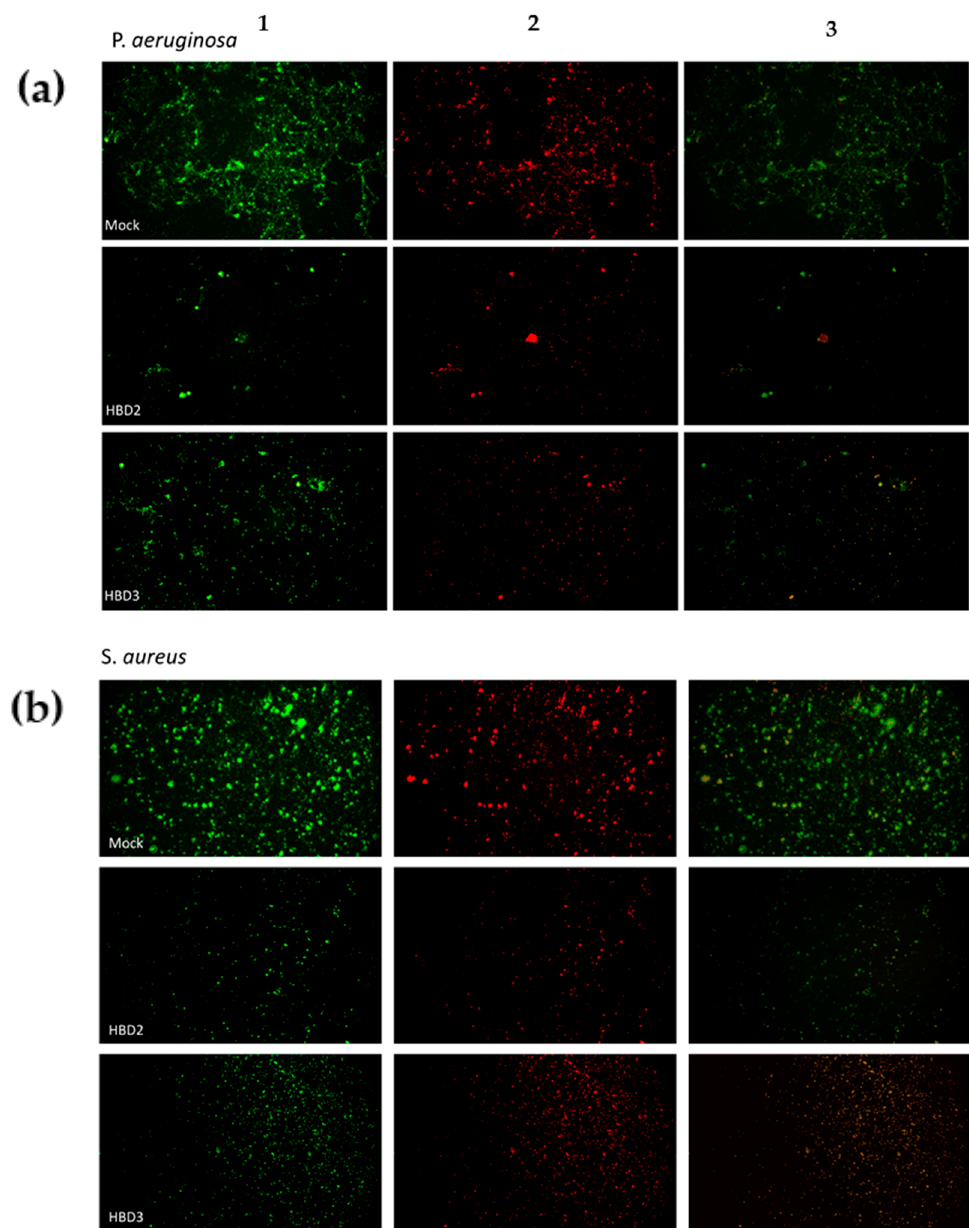
Figure 3. Live/Dead fluorescence 20 × images of biofilms of ( a ) P. aeruginosa and ( b ) S. aureus re- suspended in conditioned media of Caco-2, Caco-2/HBD-2 and Caco-2/HBD-3 cells. The panels show FITC-label (1), TRITC-label (2) and a merged image of both types of staining (3).